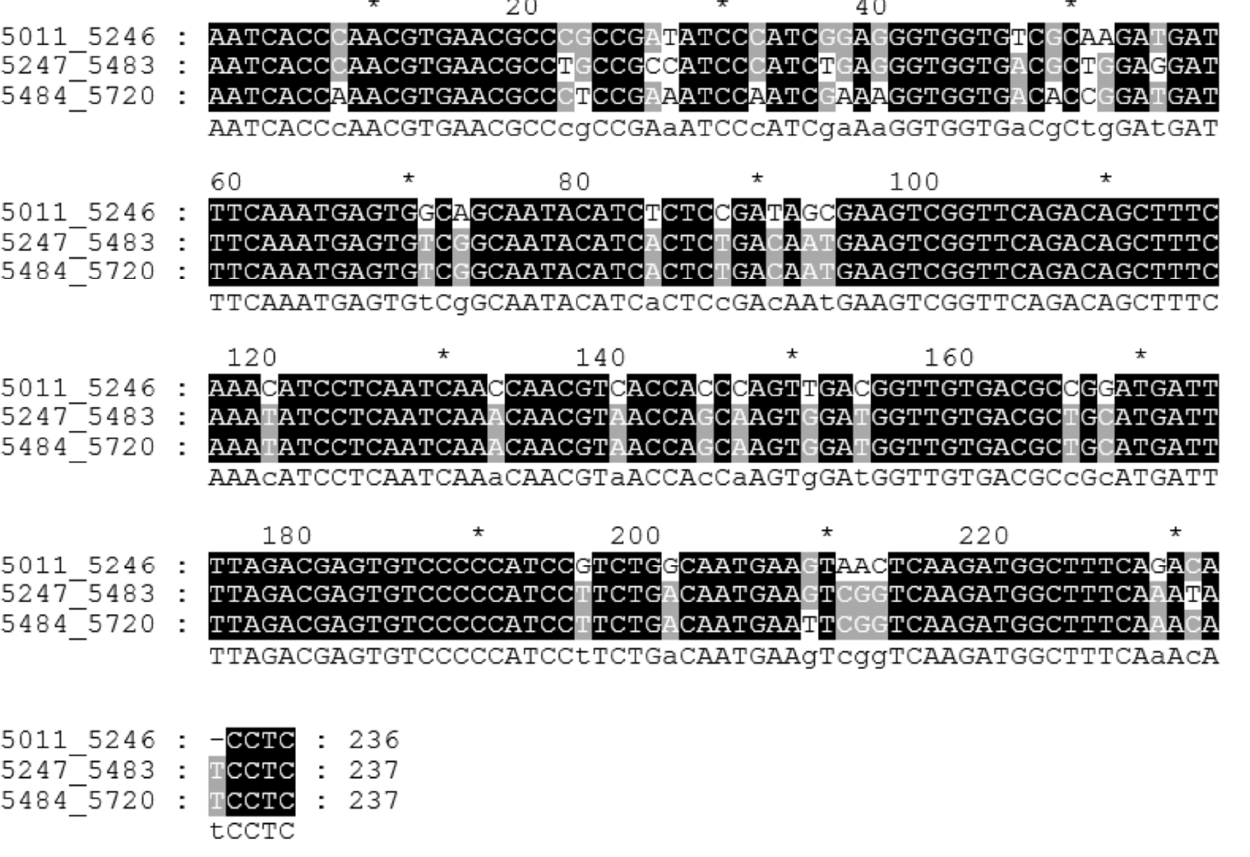
Figure 1. The alignment of the whole CS-237 monomers from scaffold 195. Codes of monomers consist of start_end nucleotide numbers in the scaffold.